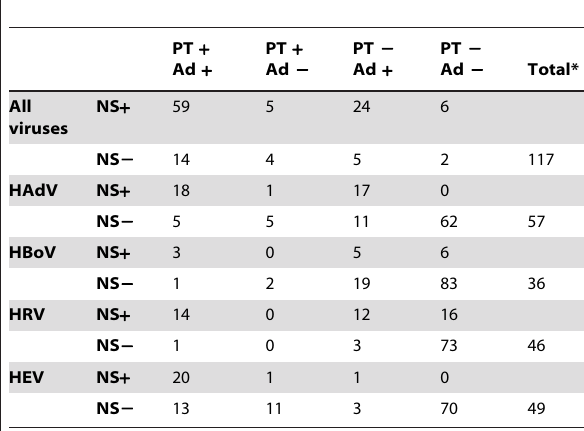
Table 2. Numbers of positive samples taken from different sites in 119 patients with chronic adenotonsillar disease from whom samples were obtained from all sites.